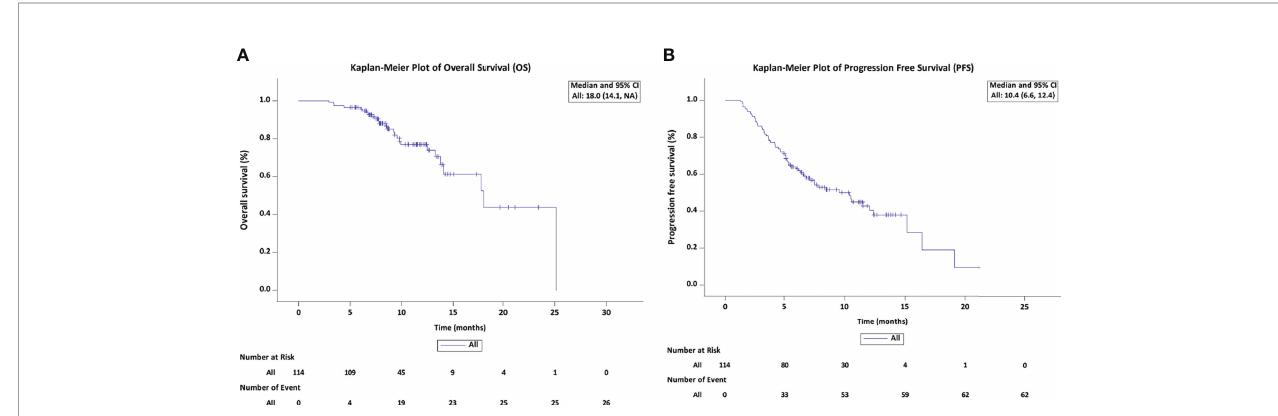
FIGURE 2 | Kaplan-Meier estimates of overall survival (A) and progression-free survival (B) in patients treated with LePD1-TACE. LePD1-TACE, lenvatinib and programmed death receptor-1 signaling inhibitors plus transarterial chemoembolization.